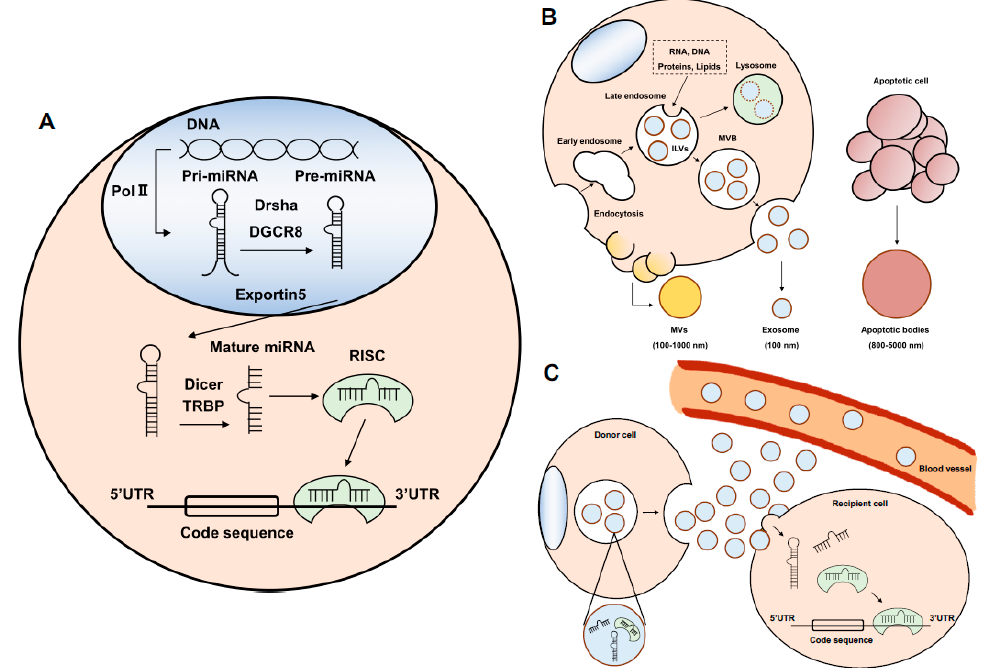
Figure 1. The biogenesis of miRNA and exosomes. ( A ) The biogenesis of miRNA. Pri-miRNA is transcribed by RNA polymerase II (Pol II). Pri-miRNA is cleaved by the microprocessor (Drsha and DGCR8) to pre-miRNA. Pre-miRNA is in the form of a hairpin. Pre-miRNA is exported from the nucleus to the cytoplasm by Exportin 5. Pre-miRNA binds to Dicer and trans-activation-responsive RNA-binding protein (TRBP) and is cut to a single RNA called mature miRNA. The miRNA binds to Argonaute (AGO) protein. This complex of miRNA and AGO protein names the RNA-induced silencing complex (RISC). The mature miRNA binds to the targeting of miRNAs with complementary sites and results in translational repression or mRNA degradation. ( B ) The biogenesis of exosomes. Exosomes are produced through the pathway of endocytosis. The origin of exosomes is the intraluminal vesicles (ILVs) in late endosomes, which develop into multivesicular bodies (MVBs) or fuse with lysosomes. At this stage, RNA, including miRNA, proteins, and lipids are encapsulated into the ILVs. These vesicles are released into the extracellular space and are called exosomes. By contrast, microvesicles (MVs) are produced from the cell membrane independently of the endocytosis pathway. Apoptotic bodies are formed from apoptotic cells. ( C ) The releasing exosomal miRNA. The exosome is transferred from the donor cells to recipient cells. The exosomal miRNAs are released into recipient cells and regulate transcription. On the other hand, some exosomal miRNAs are released into bodily fluids, such as blood, and carried to distant organs.